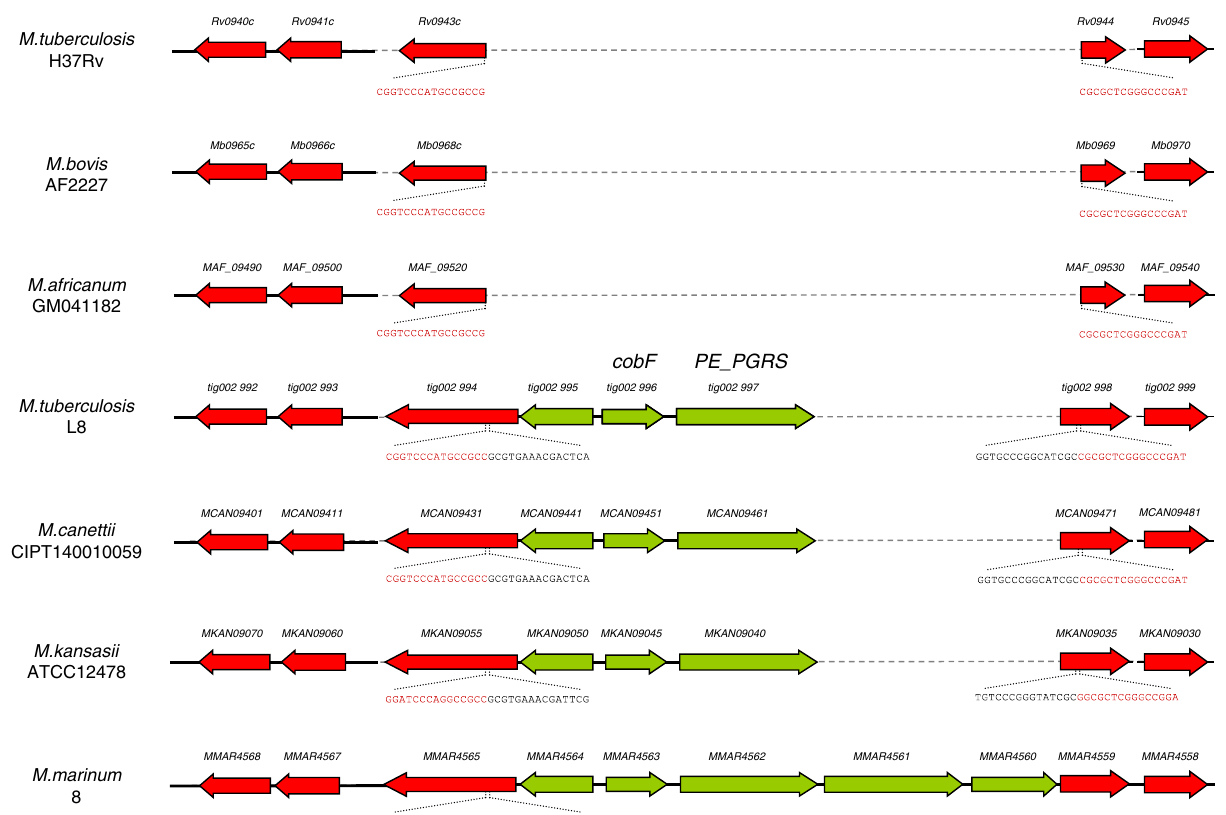
Fig. 4 Differential presence of the cobF region in speci fi c Mycobacterium spp. genomes. Aligned genome segments showing the cobF gene region in M. tuberculosis L8, M. canettii CIPT140010059 (alias STB-A), M. kansasii ATCC12478 and M. marinum M strains, and the corresponding deletion in M. tuberculosis H37Rv, M. bovis AF2122/97 and M. africanum GM041182. Coding sequences of this region are shown in green, and fl anking coding sequences in red. Sequences fl anking the deletion point in truncated genes in M. tuberculosis , M. africanum and M. bovis , and in the cobF region present in L8, M. canettii , M. kansasii and M. marinum are indicated in red and black, respectively. Dashed lines correspond to missing segment parts relatively to the longest segment found in M. marinum